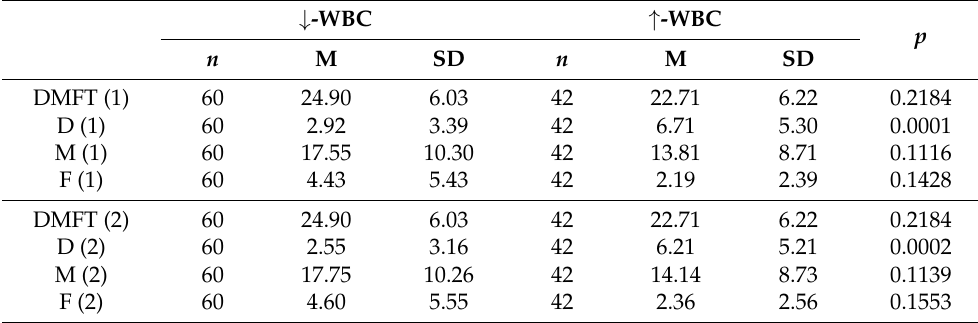
Table 3. White blood cells count change and DMFT index before (1) and after (2) chemotherapy.